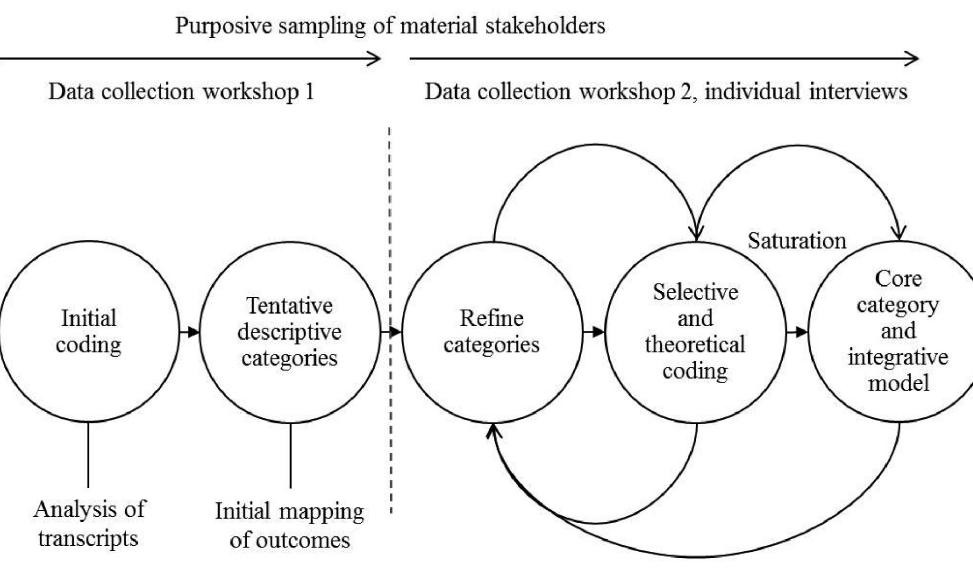
Figure 1: SROI grounded theory data collection and analysis